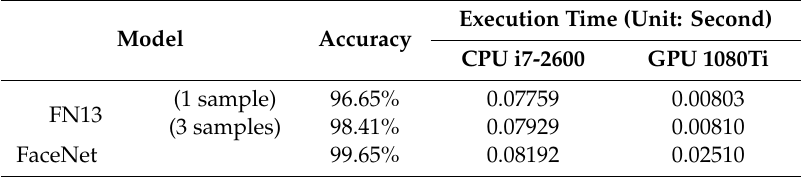
Table 5. The performance comparison in time on di ff erent platforms.